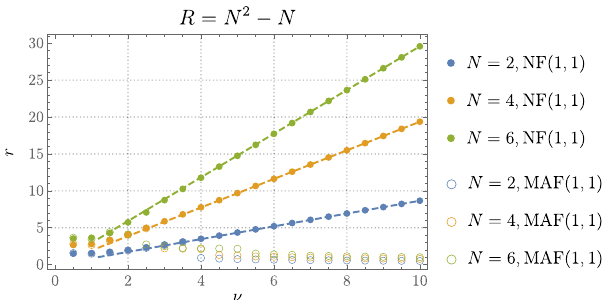
FIG. 7. Expectation value of radius in the SUSY sector of the mini-BMN model, for different N and ν . Solid dots are initialized near the fuzzy sphere configuration, and the open markers are initialized near zero. The dashed lines are the semiclassical values (4.4).